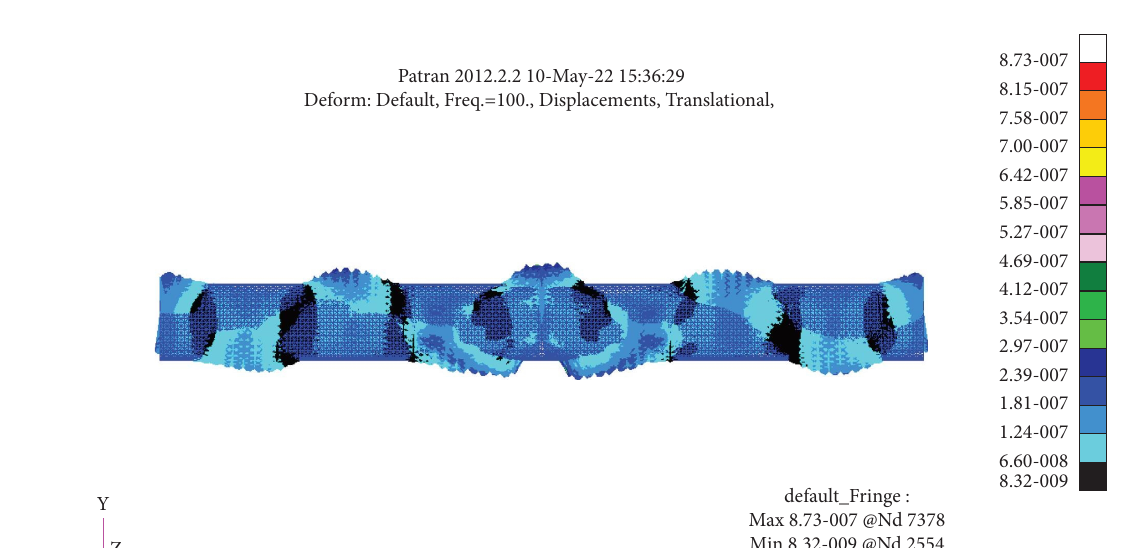
Figure 16: Te response of the structure coupled with the fuid (case 4).